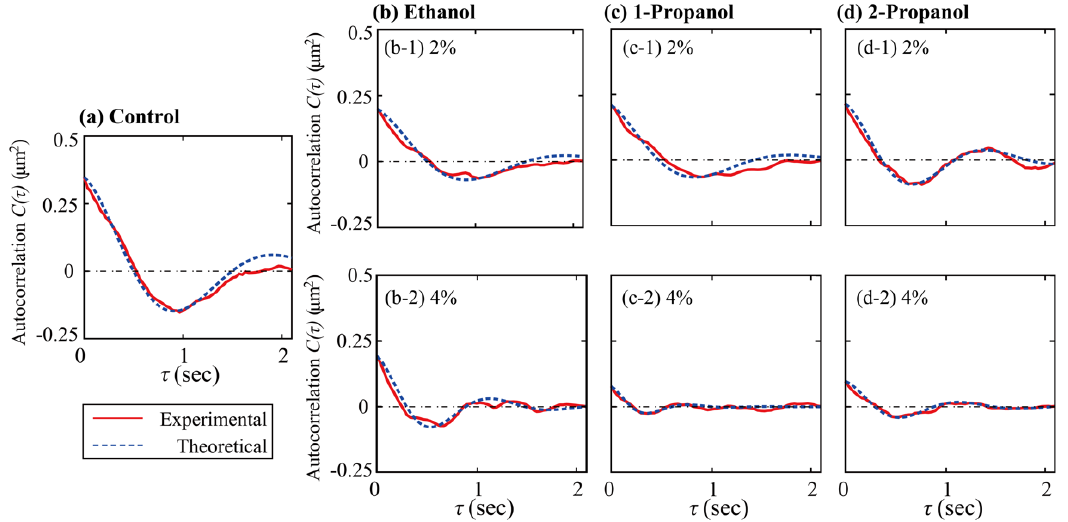
Figure 3. Time-dependent change in the long-axis length, R , of T4 GT7 DNA molecules as a measure of intrachain Brownian motion. ( a ) Time traces of the long-axis length at different solution conditions. Ggray line (control) is the measurement obtained using 10 mM Tris-HCl buffer solution at pH 7.5 with 4% (v/v) 2-ME without the addition of alcohol. The red, green, and blue lines correspond to measurements obtained using the same buffer with ethanol, 1-propanol, and 2-propanol, respectively, at 4%. ( b ) Schematic representation of the long-axis length of a single DNA molecule. ( c ) Fluorescence miscroscopic image of a single T4GT7 DNA.